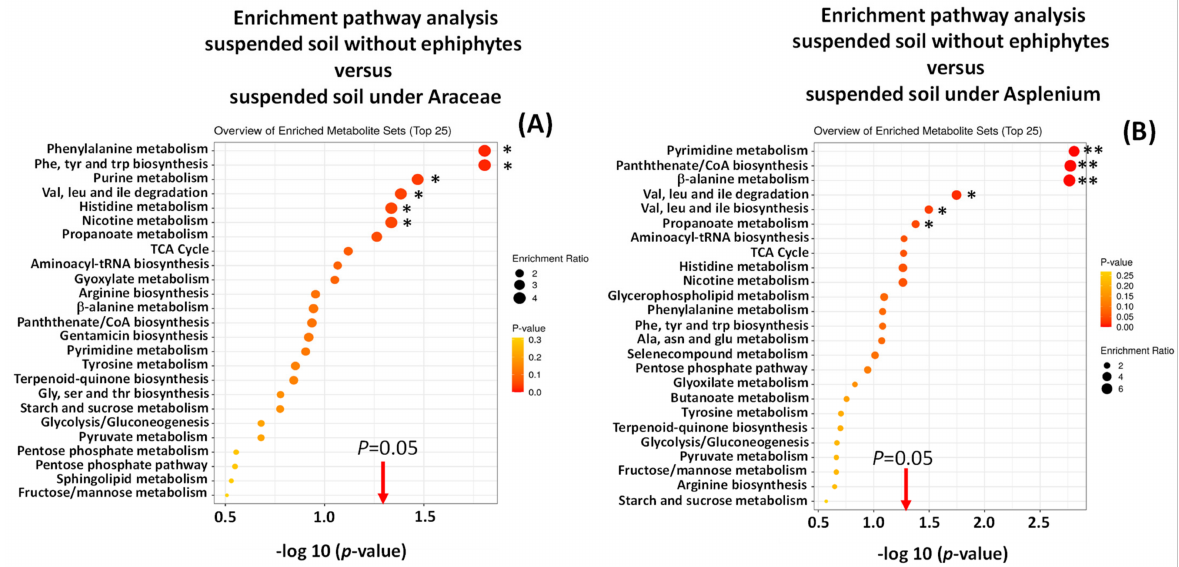
Figure 5. Enrichment pathway analysis of metabolomic profiles of suspended soils associated with Araceae ( A ) and Asplenium ( B ) compared with non-epiphyte soils. * p < 0.05, ** p <